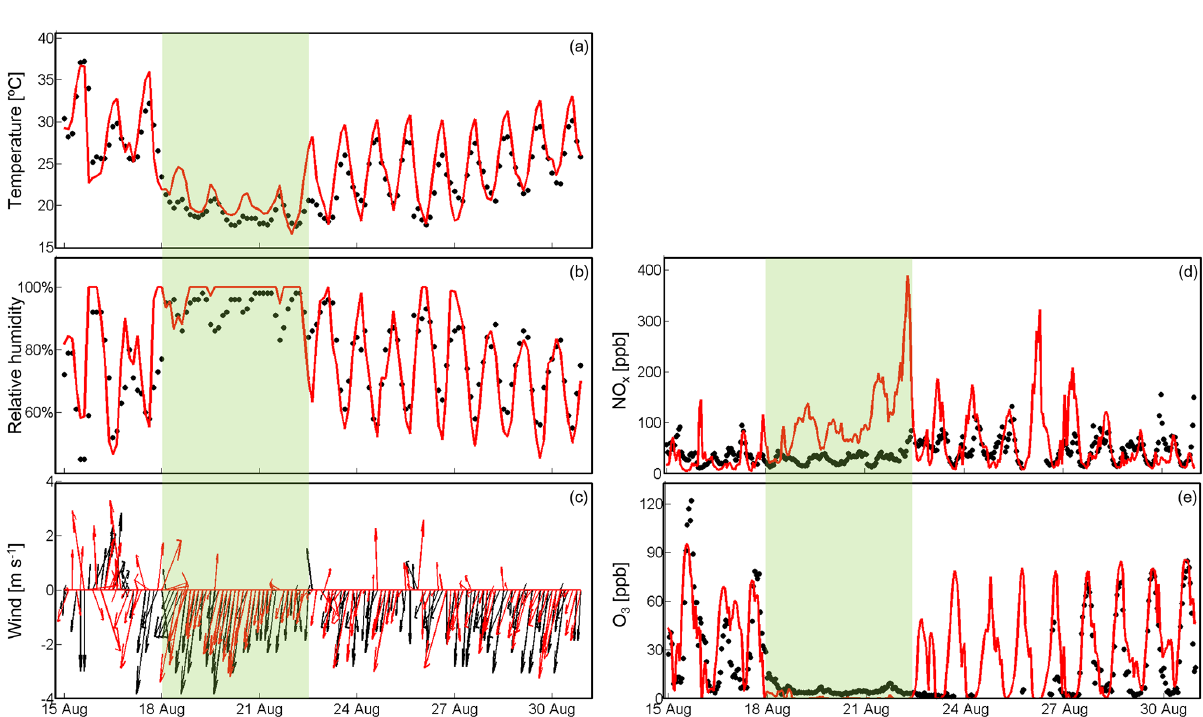
Figure 3. Observed (black) and simulated (red) temporal patterns of temperature (a) , relative humidity (b) , and wind (c) at the Jinghe site and NO x (d) and O 3 (e) concentrations at Xi’an Jiaotong University, during the period from 15 to 30 August 2011. The green shadow (18–22 August) indicates rainy